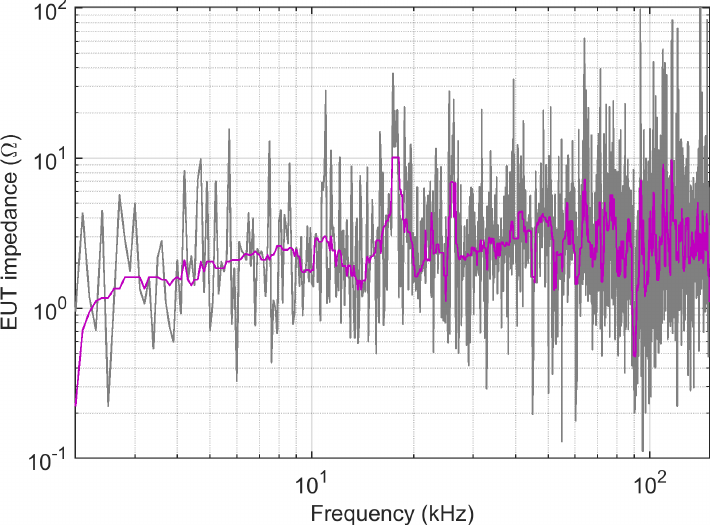
Figure 9. Estimated EUT d.m. impedance by least mean square approach: raw data (grey) and filtered